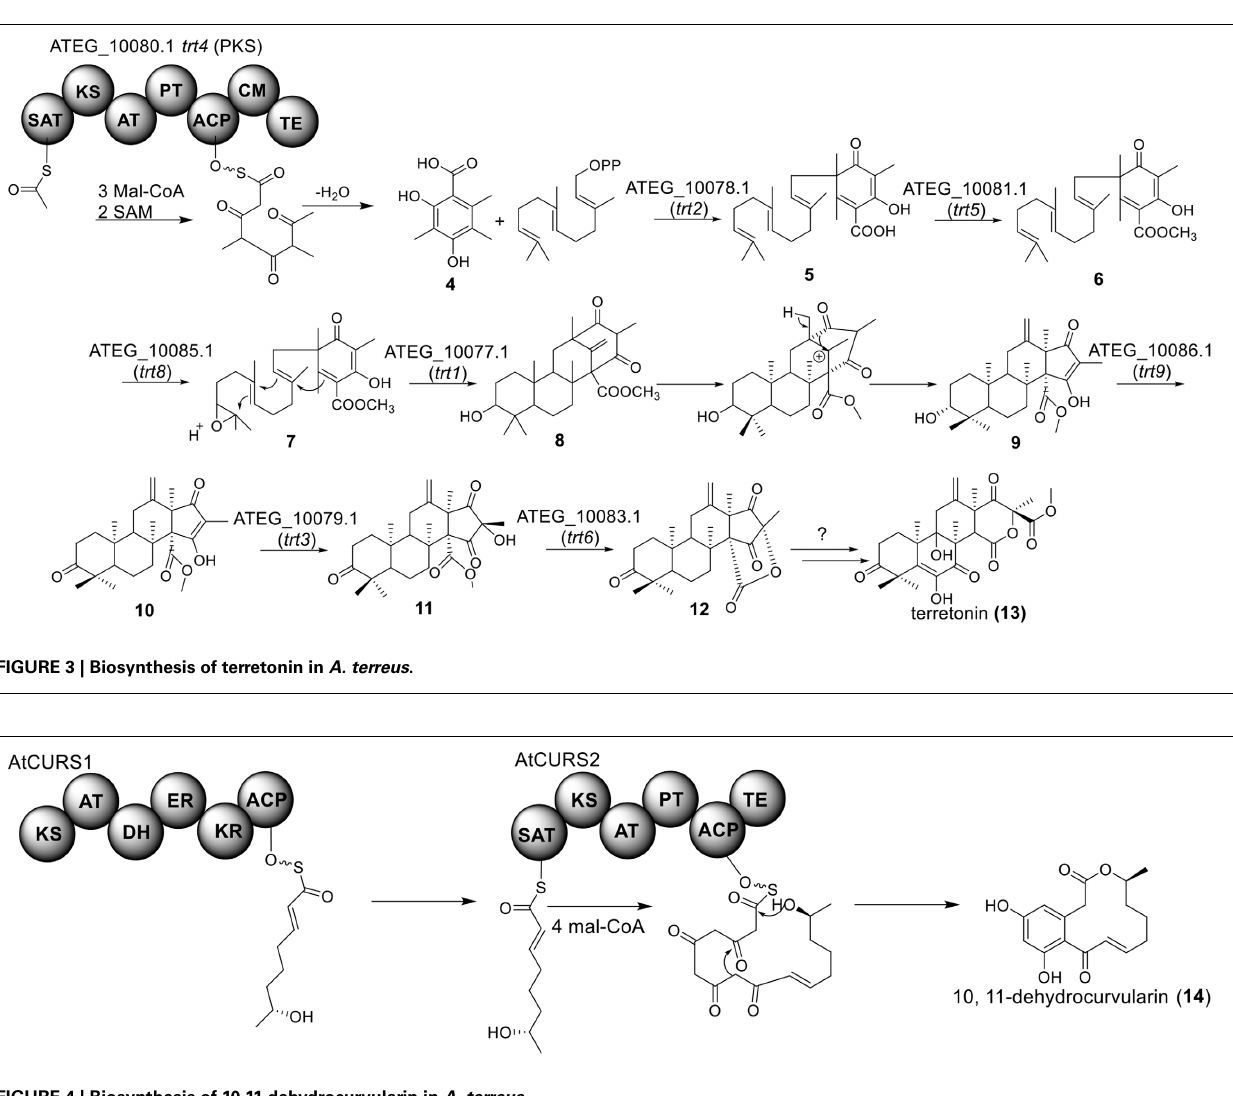
FIGURE 4 | Biosynthesis of 10,11-dehydrocurvularin in A. terreus